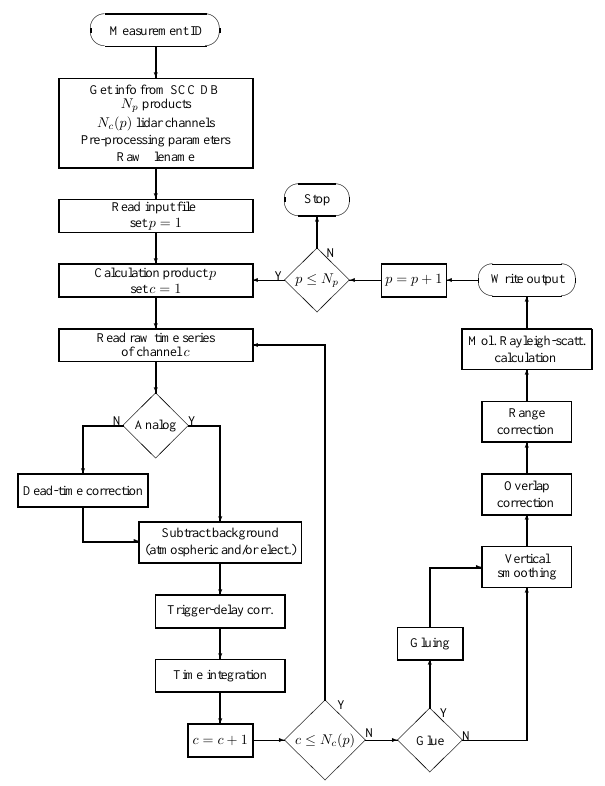
Figure 2. ELPP work flow. ELPP gets the full set of information and parameters needed for the pre-processing of a specific measure- ment ID performing suitable queries to the SCC database. This set includes how many products should be calculated ( N p ), how many lidar channels are needed for the calculation of each product ( N c (p) with 0 < p ≤ N p ), all input parameters required for the analysis (dead-time value, trigger delay, etc.), and the name of the input NetCDF file corresponding to the selected measurement ID. There are two main loops involved in the pre-processing chain: an external loop on the products to be calculated (index p ) and an internal loop in which all of the product-related channels are pre-processed se- quentially (index c ). The operations performed by the single blocks are described in the text. A single output file (intermediate NetCDF file) is generated for each